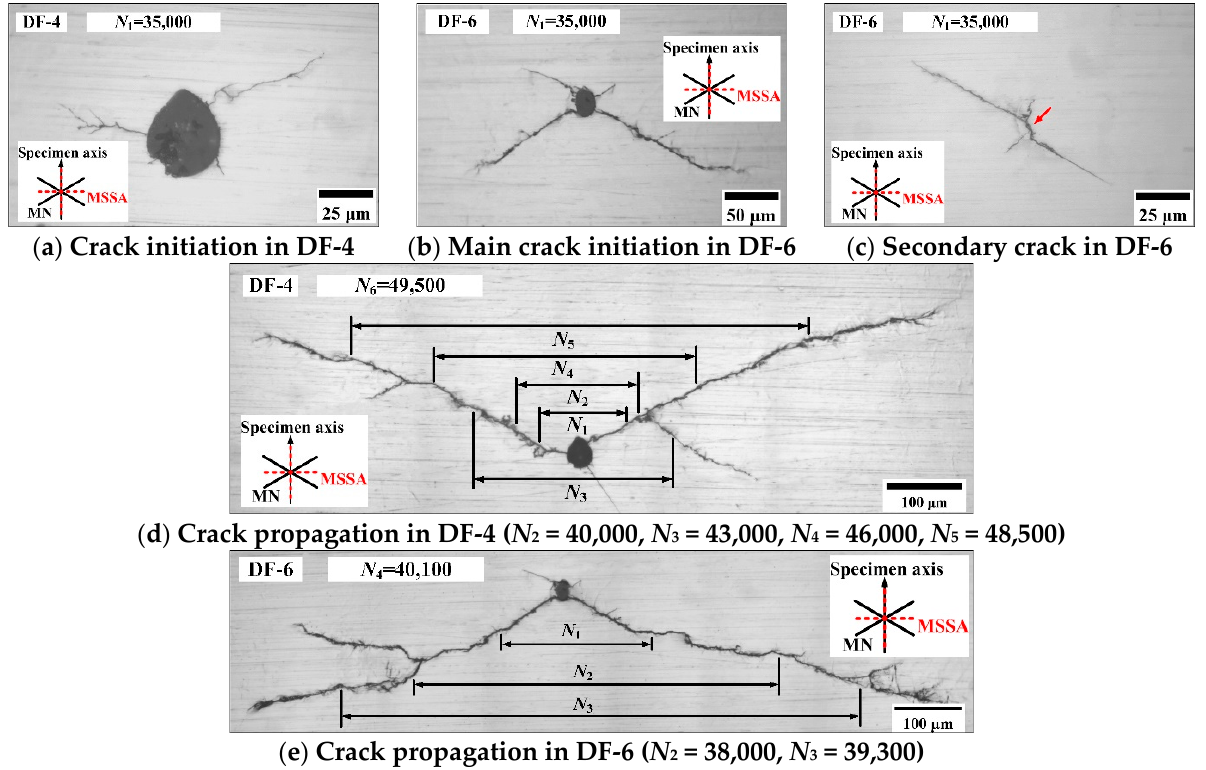
Figure 8. Crack morphologies in specimens DF-4 and DF-6.